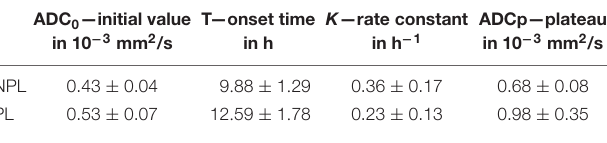
TABLE 4 | Summary of parameters from model fitting of DWI results averaged for non-perfused liver (NPL) and perfused liver (PL)